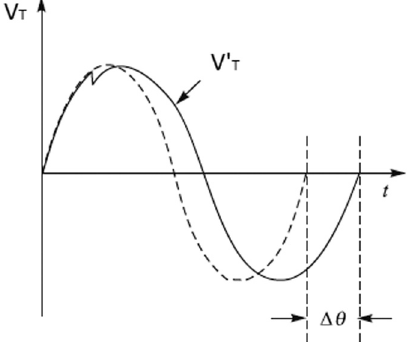
Figure 3: Voltage measured at PCC in the cycle of islanding event [ 41 ]